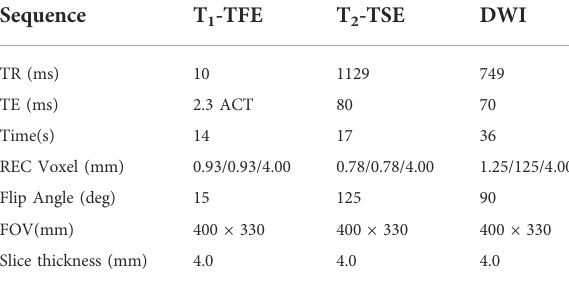
TABLE 1 Summary of sequence parameters used for